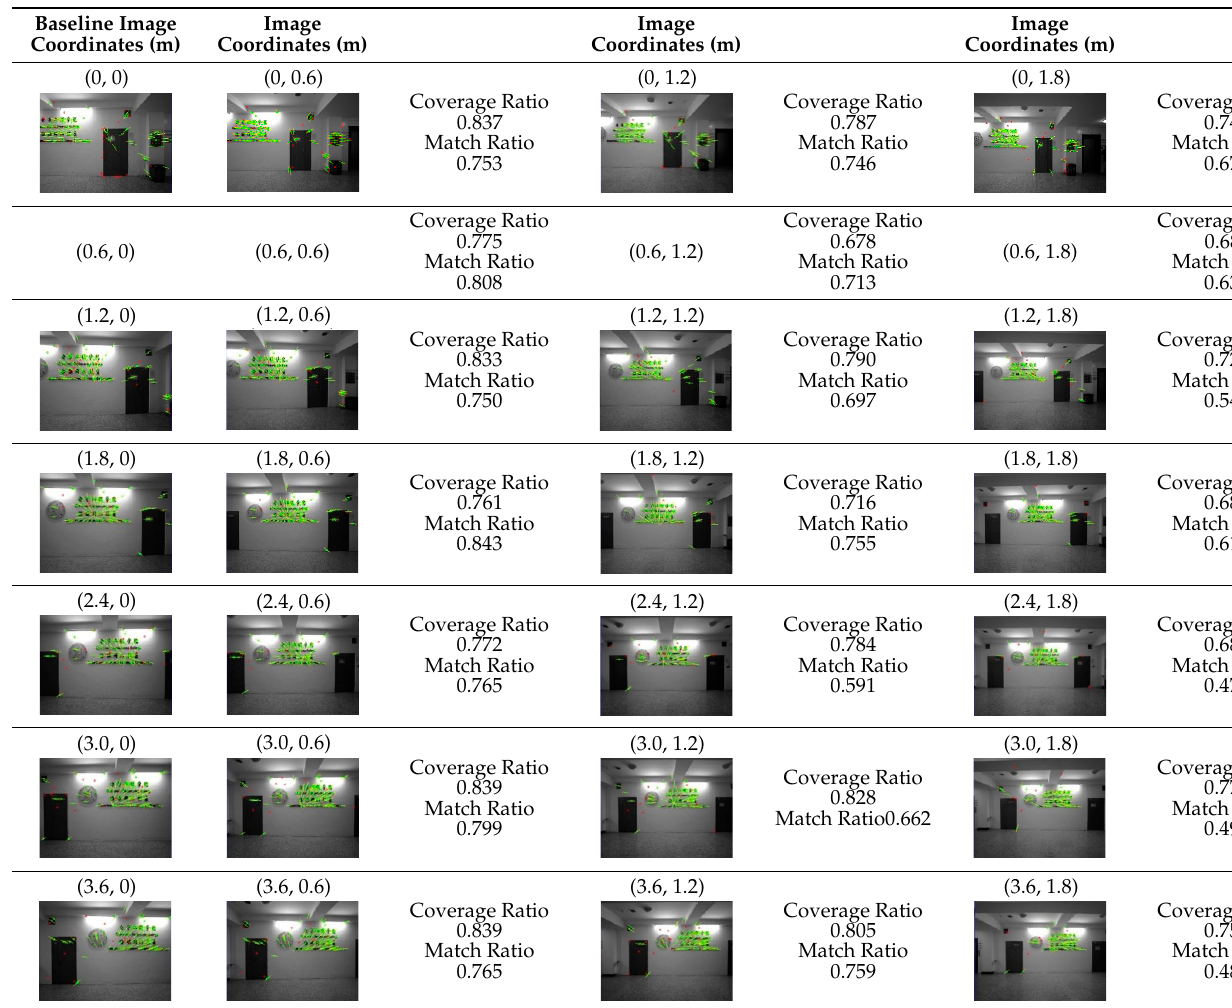
Table 1. Epipole distribution of the images collected at each coordinate point.